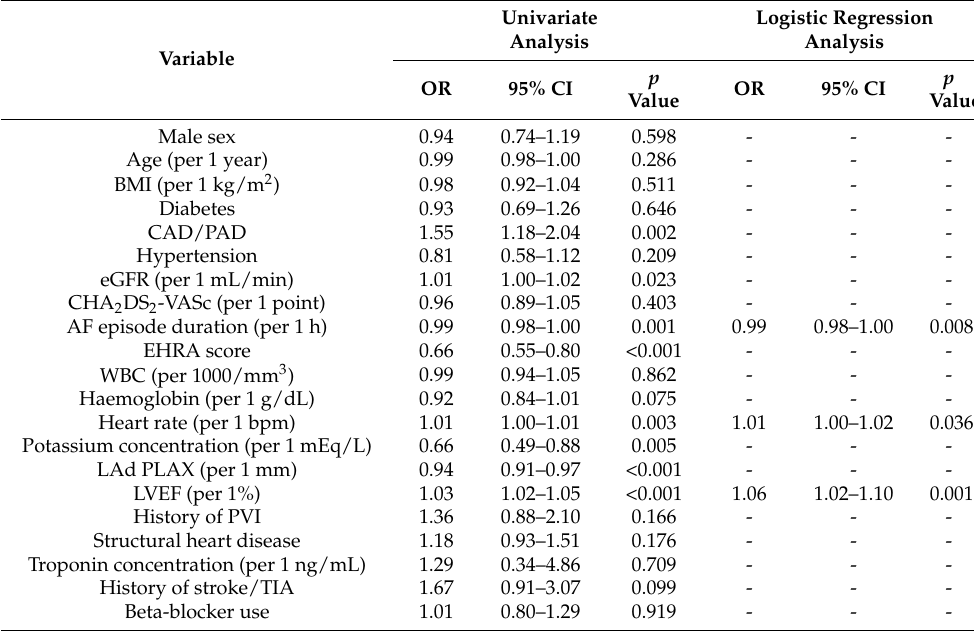
Parameters of logistic regression